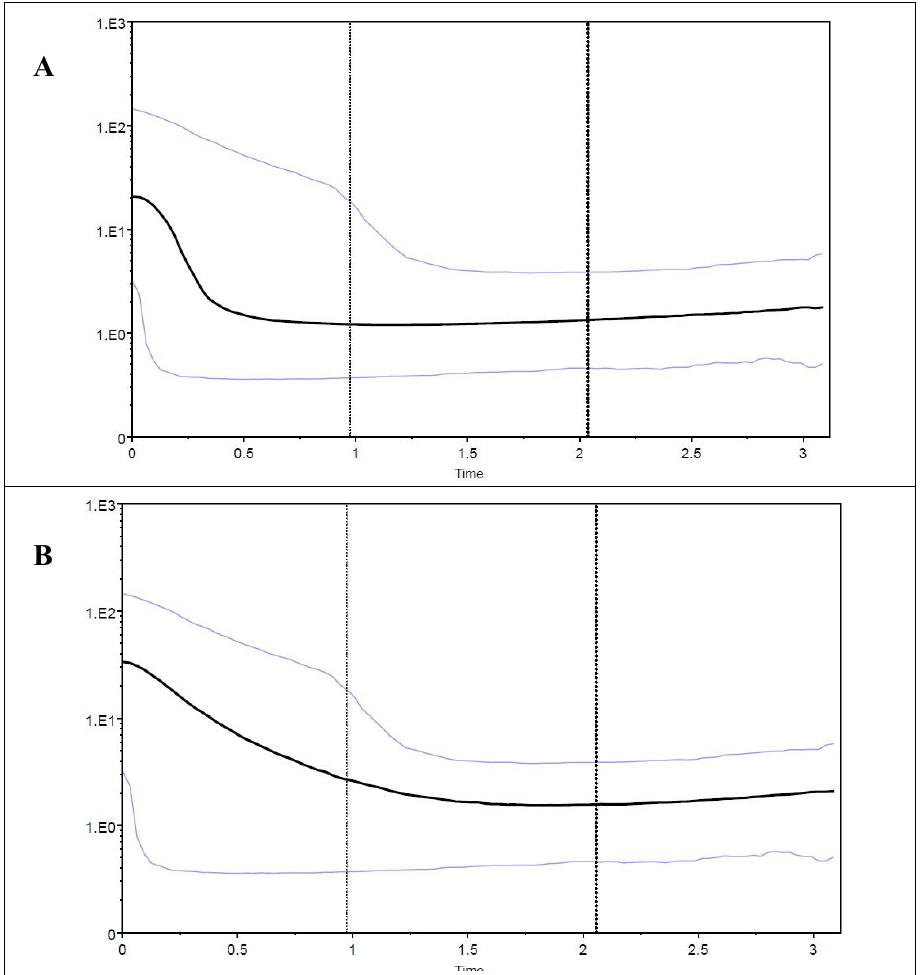
Figure 2. Two Bayesian skyline plot (BSP) analyses applied to the Sotalia guianensis population studied. ( A ) With the median; ( B ) With the mean. In both cases, although in different times, population expansion was detected in this